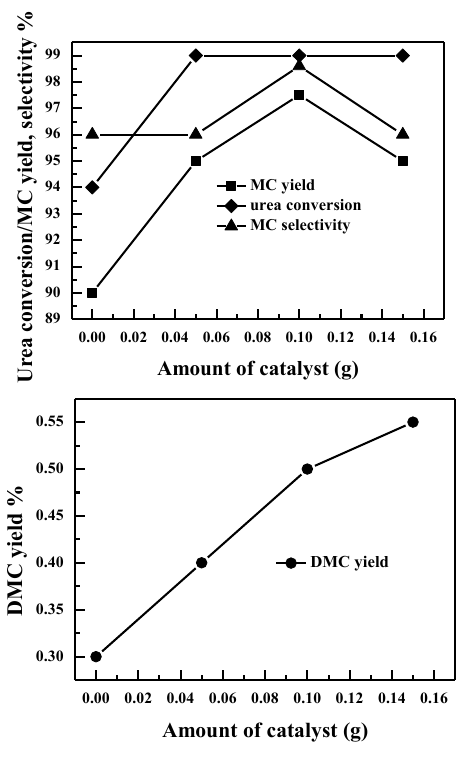
Figure 9. Effect of amount of 2.9 wt%TiO 2 /SiO 2 -500 on urea conversion, yields of 1 and 2 , and selectivity for 1 . Urea 1 g, methanol 13.5 mL, 170 °C, and 6 h.